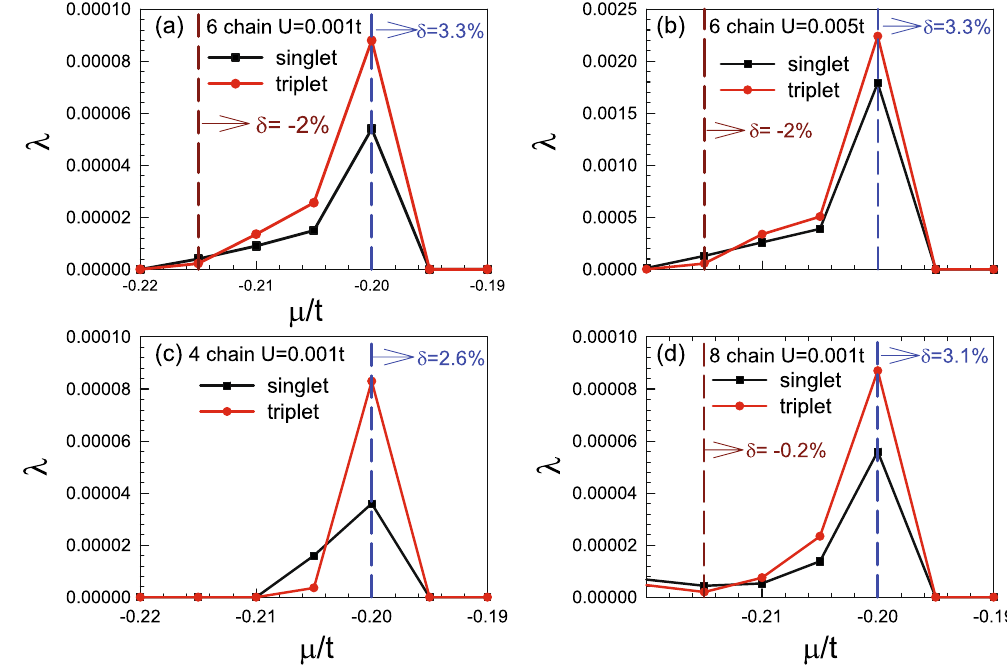
Figure 5. Doping dependence of the largest eigenvalues λ of singlet and triplet pairings for ( a ) U = 0.001 t , and ( b ) U = 0.005 t for the 6-chain system, ( c ) U = 0.005 t for the 4-chain system and ( d ) U = 0.001 t for the 8-chain